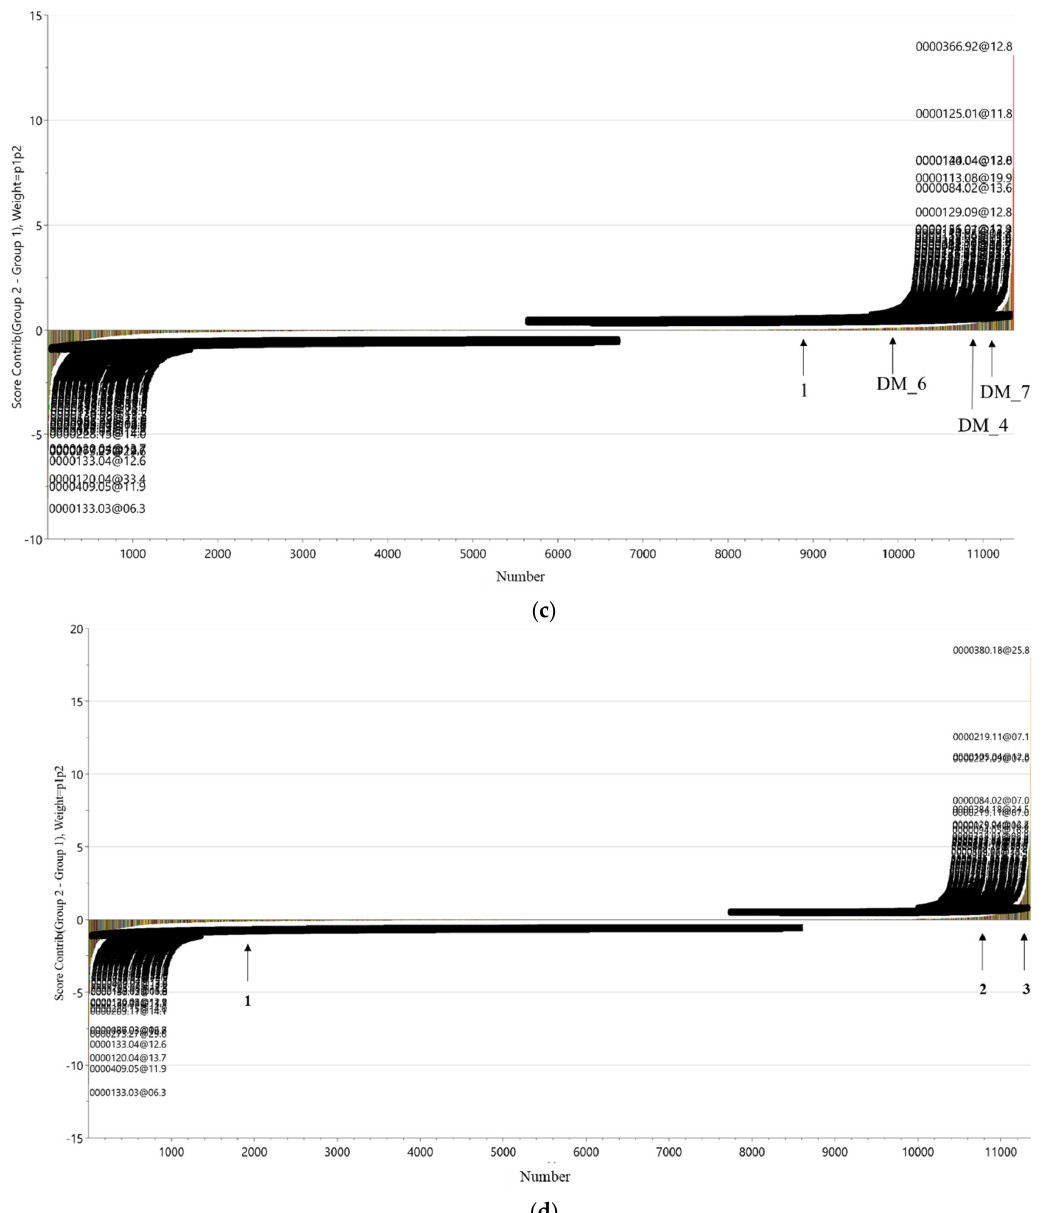
Figure 4. ( a ) S-plot of Phragmites australis control and incubated with 10 and 100 µM diclofenac samples; ( b ) S-plot of Phragmites australis control and incubated with 10 and 50 µM carbamazepine samples. The S-plot provides the visualization of the loading components (green color) of OPLS-DA to enable the interpretation of the data. The red-labeled compounds represent the differentiating metabolic profile (DMF) of each incubation; ( c ) the contribution plot shows the up- and down-regulated compounds due to the incubation of Phragmites australis with 10 and 100 µM diclofenac, individually. Down-regulated compounds have negative values, while up-regulated compounds have positive values. (1) Quercetin, DM_6, DM_4 and DM_7 have up-regulated in Phragmites australis due to incubation with diclofenac at (8820, 0.0385581), (9968, 0101411), (10,817, 0.279365) and (10,985, 0.389), respectively; ( d ) the contribution plot of Phragmites australis with 10 and 50 µM carbamazepine, individually. Down-regulated compounds have negative values as compound 1 which was quercetin at (2033, − 0.118706). Up-regulated compounds have positive values as compounds 2 and 3 which were 2,3-di- hydro-2,3-dihydroxycarbamazepine at (10,921, 0.288274) and carbamazepine-10,11-epoxide at (11,270, 1.27941), respec- tively.